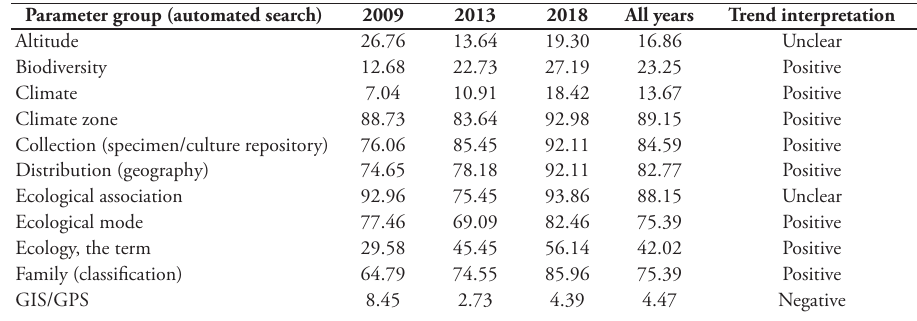
Table 2. Estimates obtained by the automated and manual parsing of the PDF files, broken down to three individual years (columns 2–4) as well as overall (column 5). Column 6 indicates our interpretation of the mycological repercussions of the trend in the data. Suppl. material 2 breaks down these estimates onto the individual 1,097 mycological papers, and Suppl. material 1 shows the full syntax used to query the individual papers for each parameter group in column 1. The following estimates are given in per cent. Altitude – alti- tude of sampling. Biodiversity – whether the term “biodiversity” was mentioned. Climate – whether the